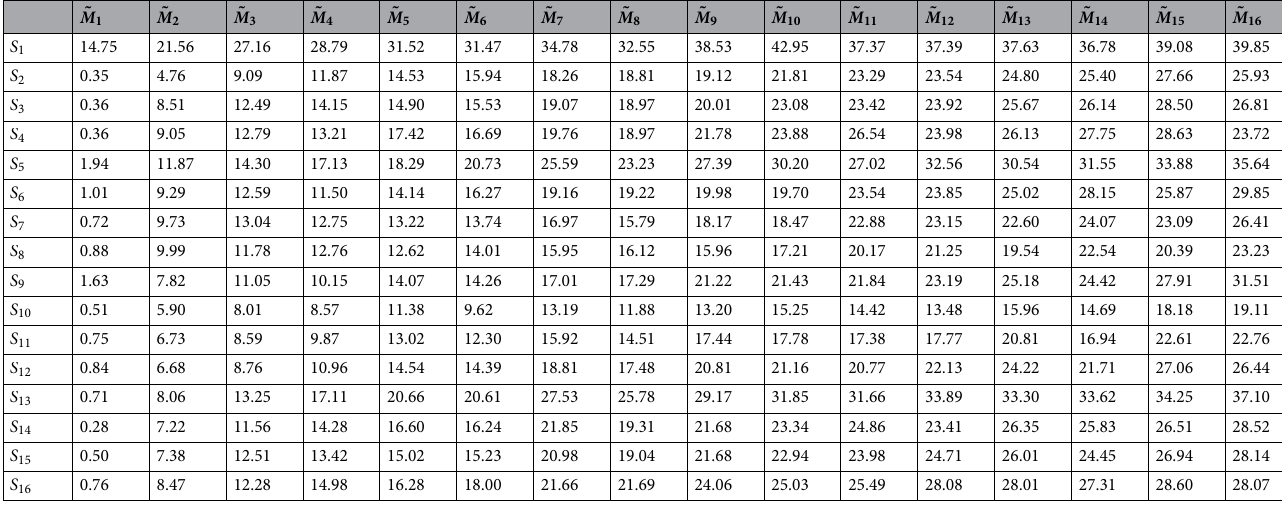
Table 2. Classification accuracies of 16 DL models on a testing sets of 16 subkeys (Increasing number of traces in the training